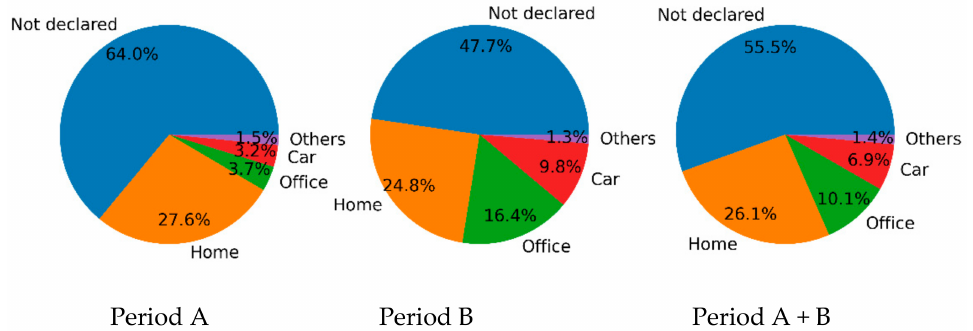
Figure 4. Distribution of the activities per period.